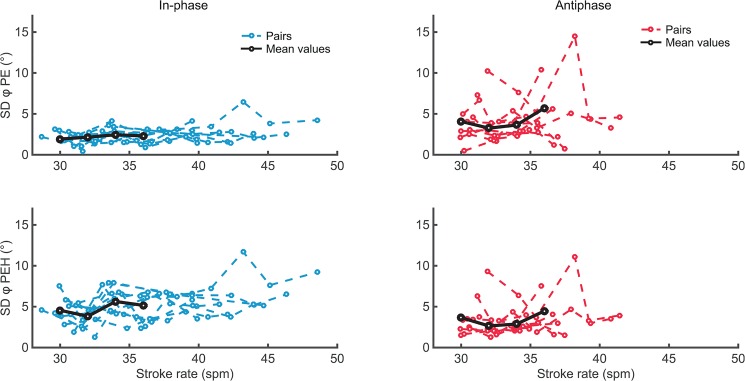
Variability of discrete relative phase.Values based on trunk movements (upper panels) and handle movements (lower panels) for in-phase (left panels) and antiphase (right panels) crew coordination depicted against performed stroke rates for all eleven dyads. Black lines indicate the means over the eight dyads as used in the RM ANOVA for stroke rates 30–36.